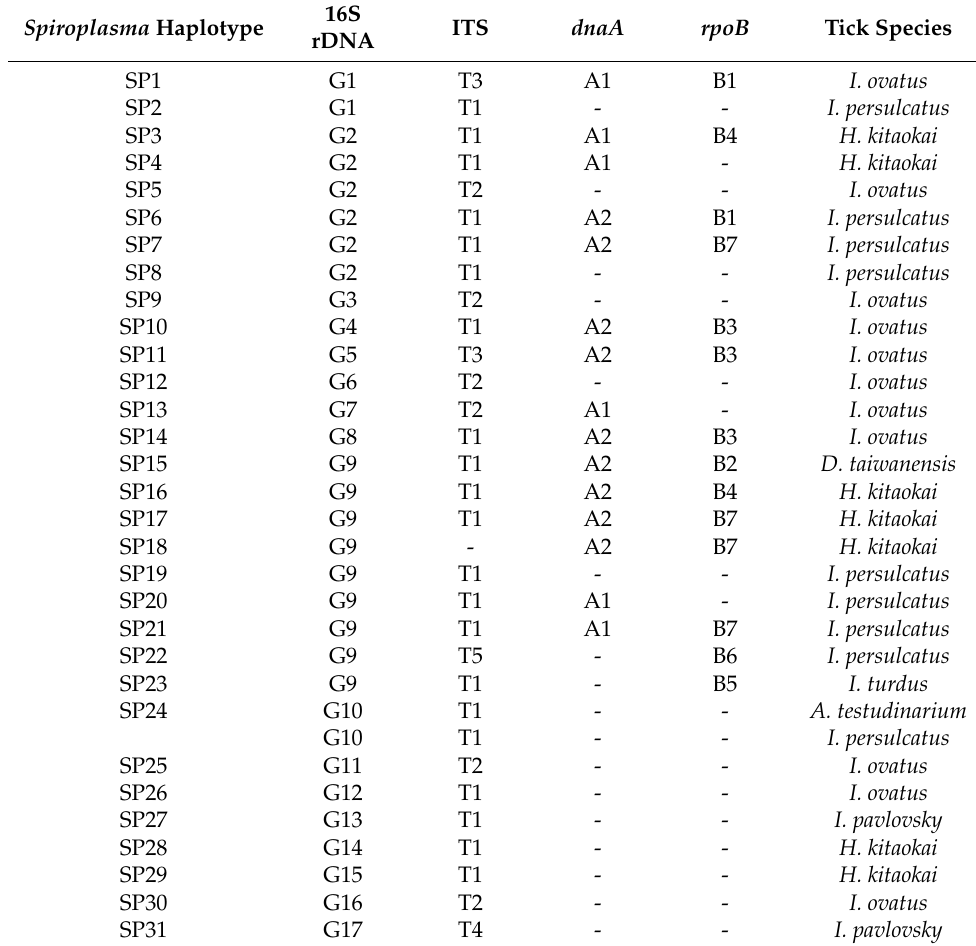
Table 3. Multi-locus sequence typing of Spiroplasma in ticks. Spiroplasma Haplotype